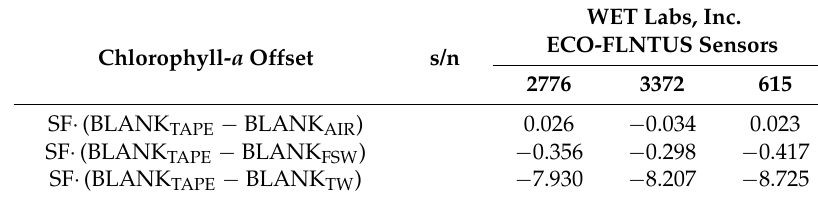
Table 1. Difference of chlorophyll- a concentration in unit of µ g ¨ L ´ 1 computed using different BLANK values (air, filtered sea water, tap water) with respect to using BLANK value obtained with the detector covered by the black tape.